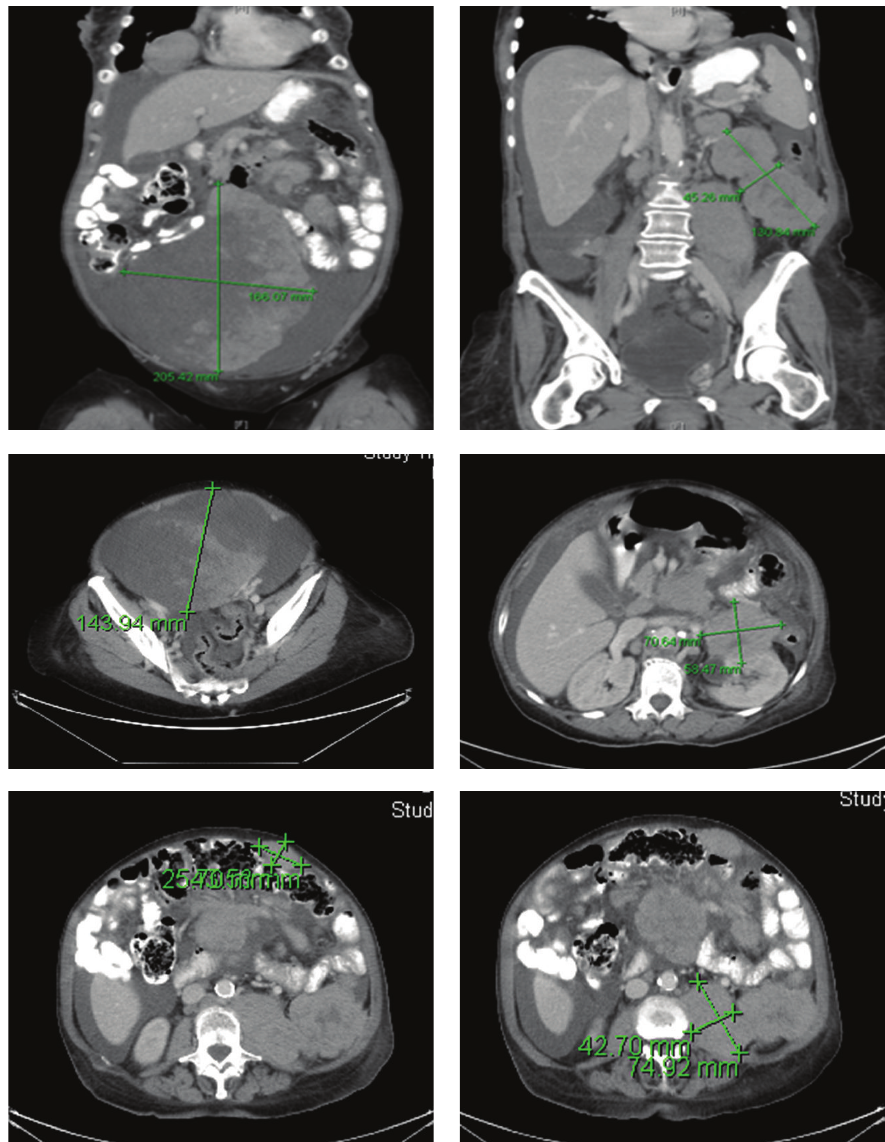
Figure 1: Computer tomography of the abdomen showing multiple intra-abdominal/pelvic masses and massive